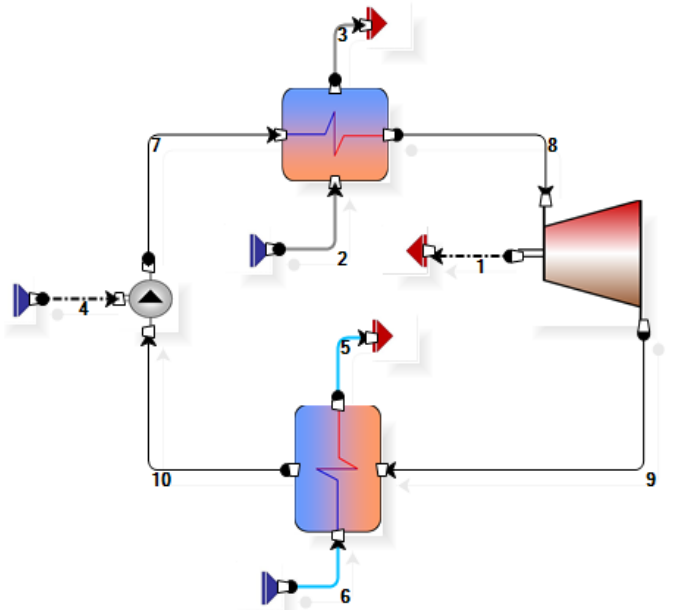
Figure 2. Layout with R134a and